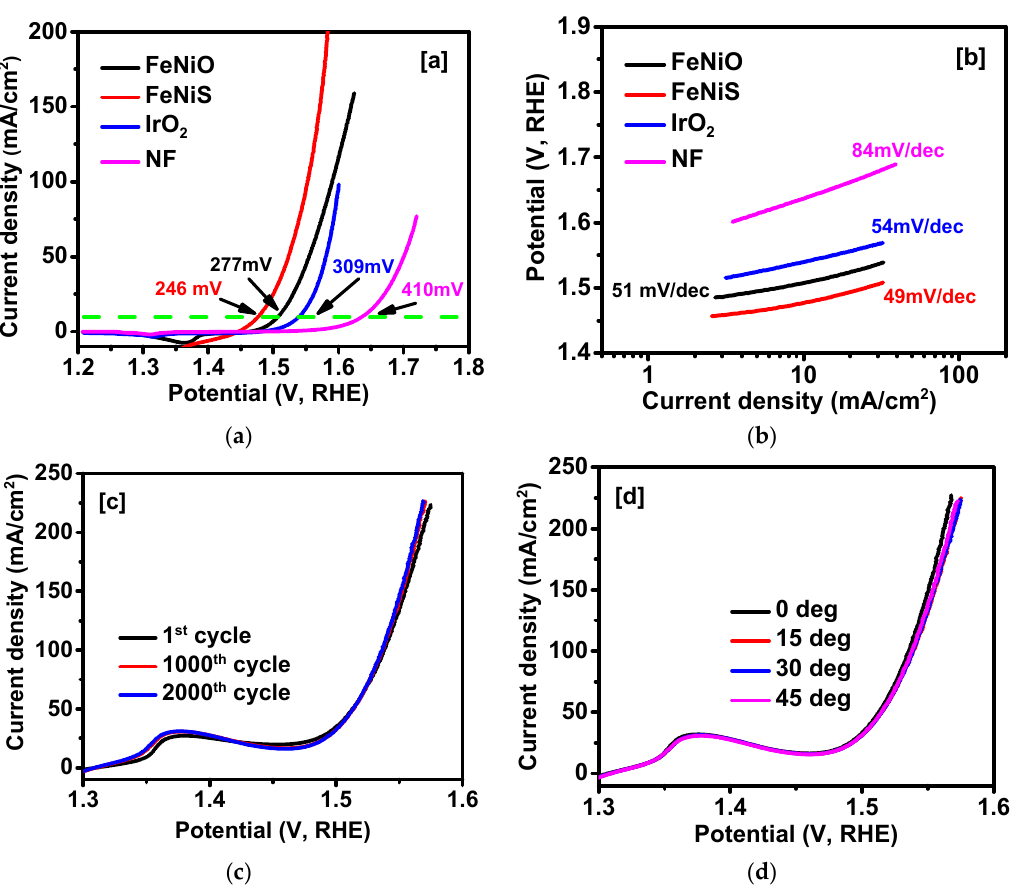
Figure 3. ( a ) Polarization curves for OER, ( b ) Tafel slopes for FeNiO, FeNiS, IrO 2 and NF, ( c ) LSV curves during stability test for OER and ( d ) LSV curves at different bending angles.